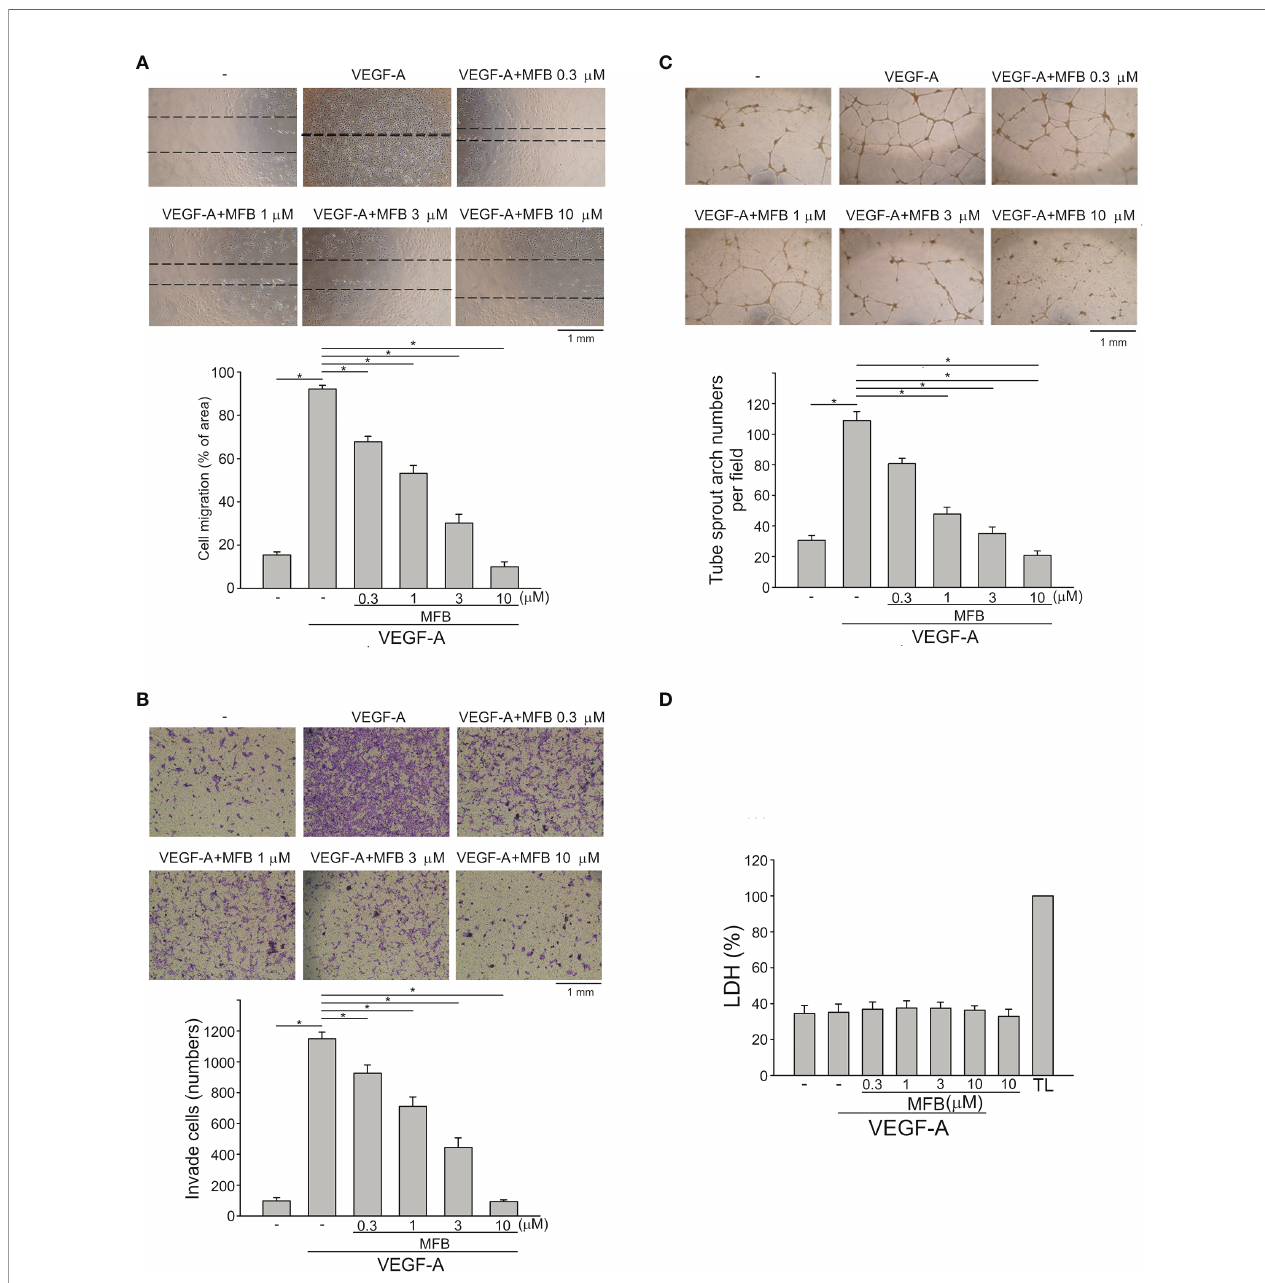
FIGURE 1 | MFB suppressed VEGF-A-induced cell migration, invasion, and tube formation of HUVECs in vitro and reduced VEGF-A-induced aorta ring sprouting ex vivo. ( A ) HUVECs were starved in 2% FBS containing medium without ECGS for 18 h After starvation, cells were scratched and treated with vehicle or MFB in the absence or presence of VEGF-A for another 24 h. The rate of cell migration was determined. Each column represents the mean ± S.E.M. of six independent experiments * P <.05, signi fi cantly different from VEGF ‐ A alone; one ‐ way ANOVA, with Tukey ’ s post ‐ hoc test. (B) After starvation as described in (A) , a total of 2 x 10 4 HUVECs were seeded in the top gelatin-coated chamber and treated with vehicle or MFB using VEGF-A as a chemo-attractant. After 18 h, the HUVECs that invaded through the gelatin-coated membrane barrier were stained and quanti fi ed. Each column represents the mean ± S.E.M. of eight independent experiments. *P <.05, signi fi cantly different from VEGF ‐ A alone; one ‐ way ANOVA, with Tukey ’ s post ‐ hoc test. (C) HUVECs were seeded on Matrigel in the presence of VEGF-A (200 ng/ml) with or without MFB. Cells were photographed under phase-contrast after 18 h Bar graphs show compiled data of average sprout arch numbers (n = 6). *P <.05, signi fi cantly different from VEGF ‐ A alone; one ‐ way ANOVA, with Tukey ’ s post ‐ hoc test. (D) Cells were stimulated with VEGF-A (25 ng/ml) with or without MFB for 18 h An LDH assay was used to determine the cytotoxicity of MFB. Cells were also treated with cell lysis buffer (total lysis, TL) to serve as a positive control (100%). Each column represents the mean ± S.E.M. of six independent experiments performed in duplicate. Technical replicates were used to ensure the reliability of single values for each experiment. *P <.05, signi fi cantly different from VEGF ‐ A alone; Kruskal – Wallis